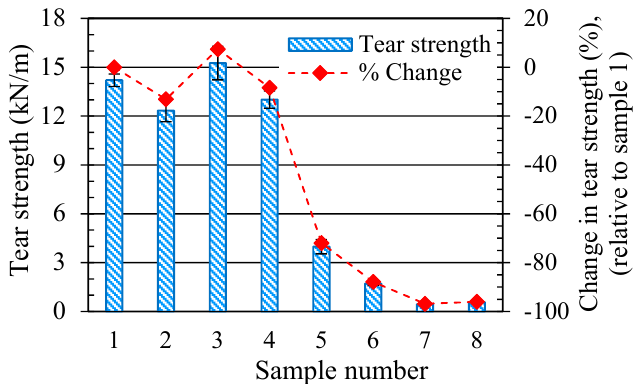
Figure 4. Variations of the tear strength of SR with ageing conditions.